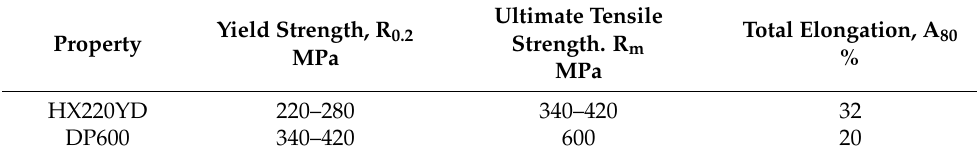
Table 1. Chemical composition (max. values) of HX220YD steel (in wt.%; acc. to EN 10346) and of DP600 steel (in % by weight; acc. to EN 10338) [25,27,28]. Cr + V Material C Si Mn P S Al Nb Ti Cu * Mo HX220YD 0.01 0.2 0.9 0.08 0.025 0.1 DP600 Table 2. Mechanical properties of HX220YD steel (acc. to EN 10346) and of DP600 steel (acc. to EN 10338) [25,28]. Ultimate Tensile Total Elongation, A 80 Yield Strength, R 0.2 Strength. R m Property % MPa MPa HX220YD 220–280 340–420 32 DP600 340–420 600